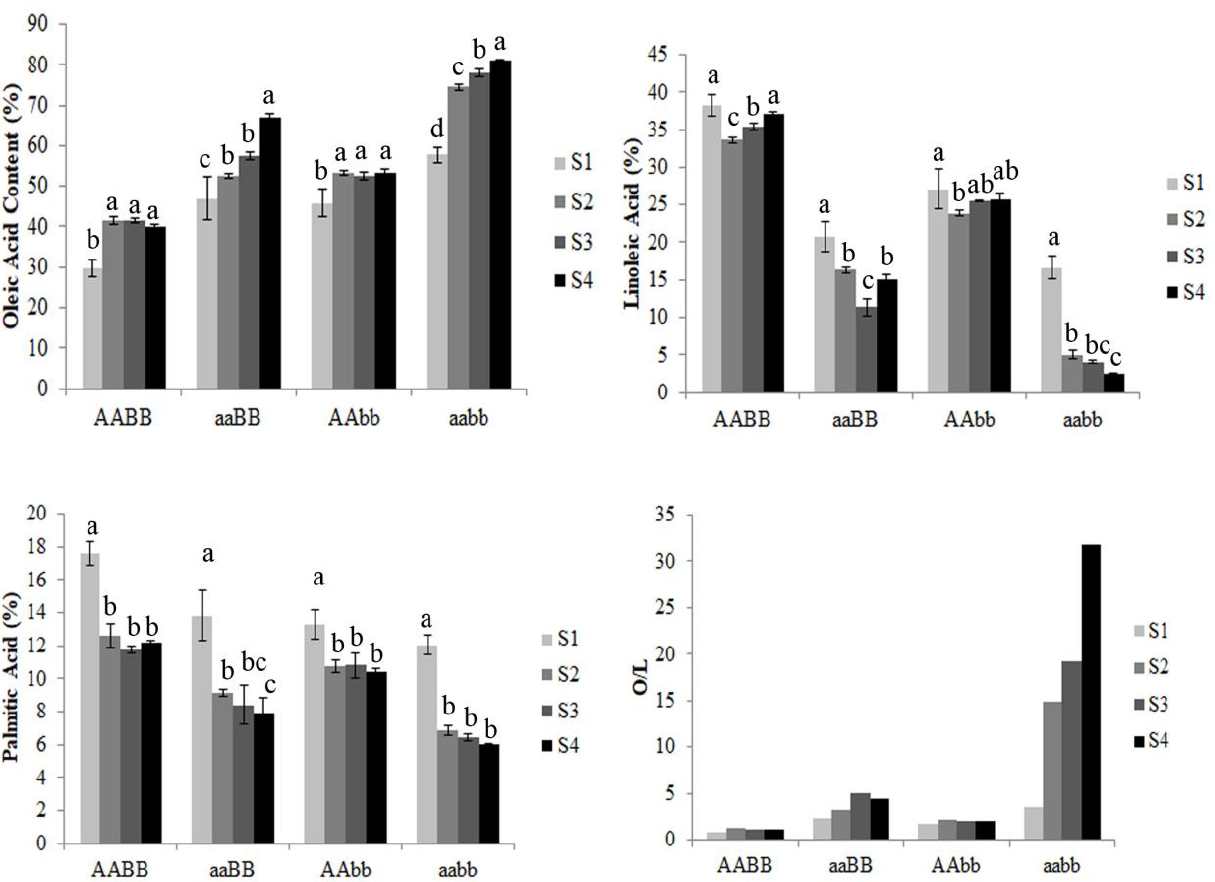
Figure 2. Fatty acid content and oleic-acid-to-linoleic-acid ratio of four genotypes AABB, aaBB, AAbb, aabb in different developmental stages of peanut seeds.